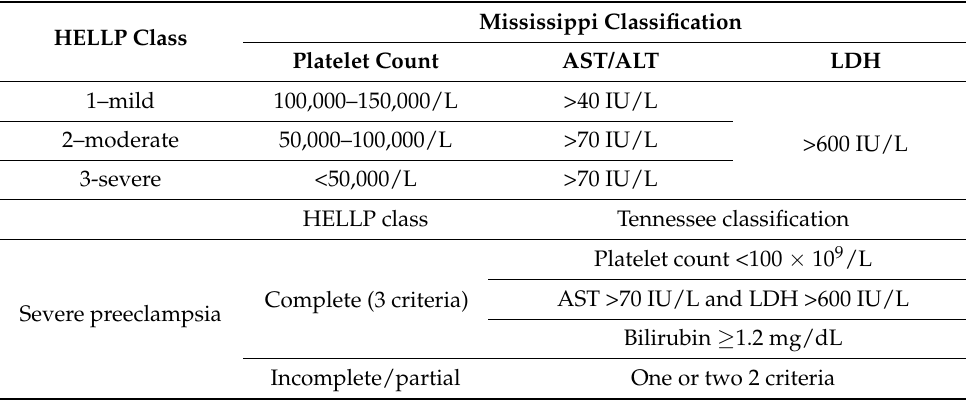
Table 6. Forms of HELLP syndrome according to Mississippi and Tennessee classifications. Data from Ref.